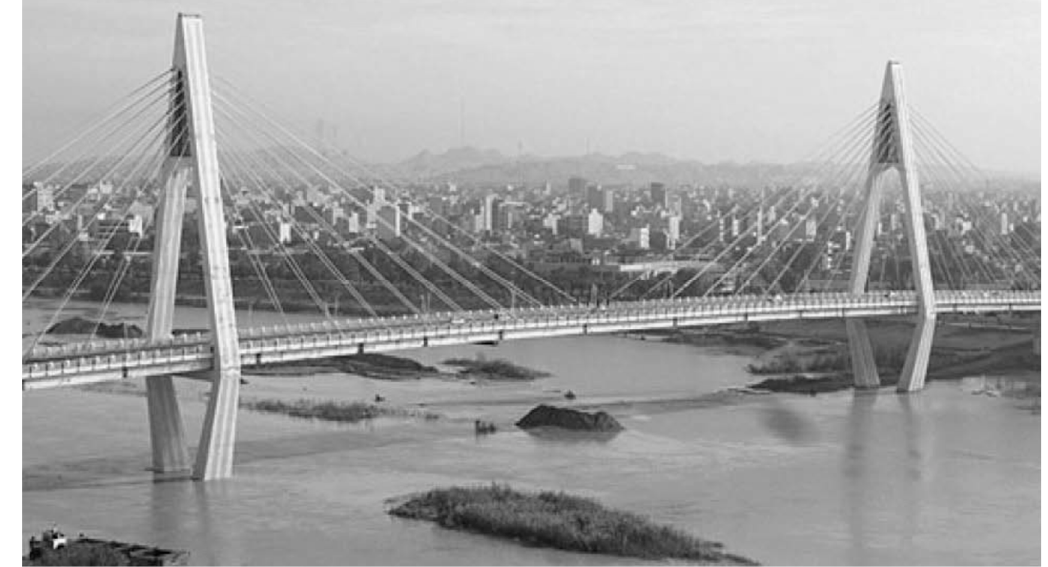
Figure 1. Photograph of the 8th bridge of Ahvaz on the Karun river,